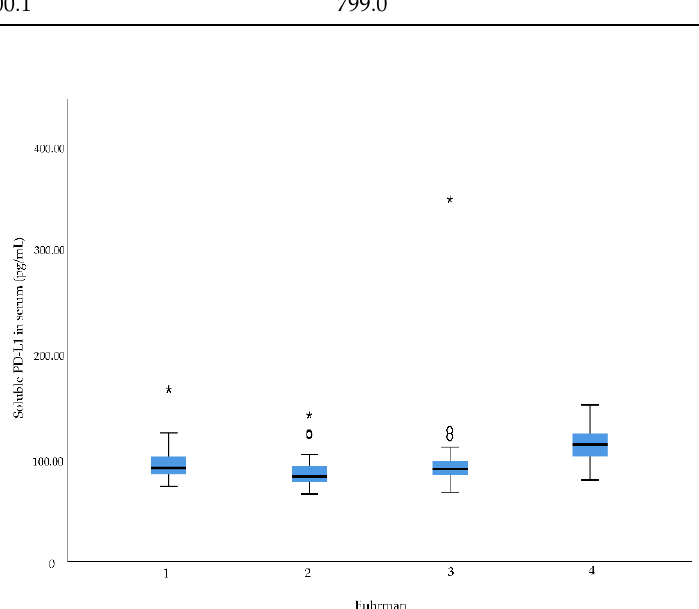
Figure 1. Soluble programmed death ligand 1 (sPD-L1) serum levels in renal cell carcinoma patients with different Fuhrman grades. Higher sPD-L1 level was associated with higher Fuhrman grade, p = 0.001. Outliers in the data are represented by a circle ( ◦ ), and extreme outliers are represented by an asterisk